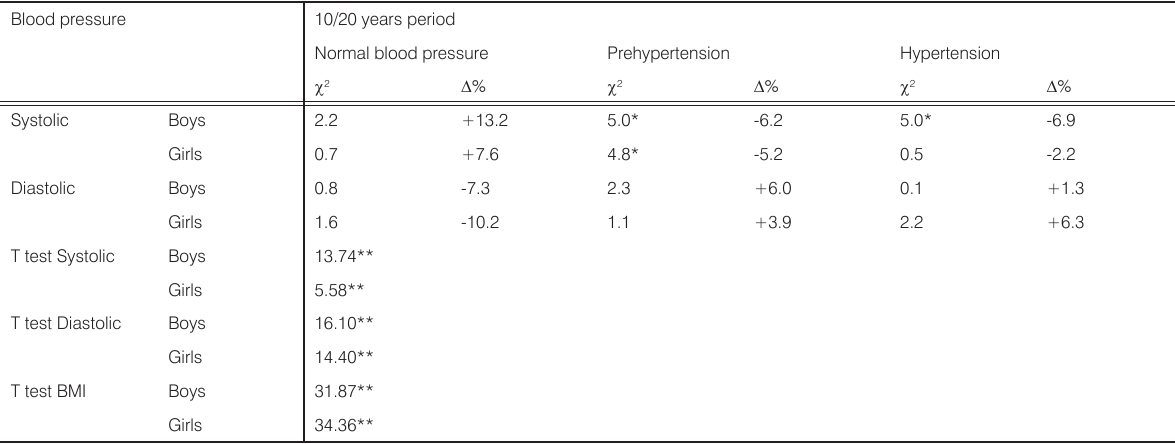
Table 4 Evaluation of blood pressure and BMI in children age between 10 and 20 years